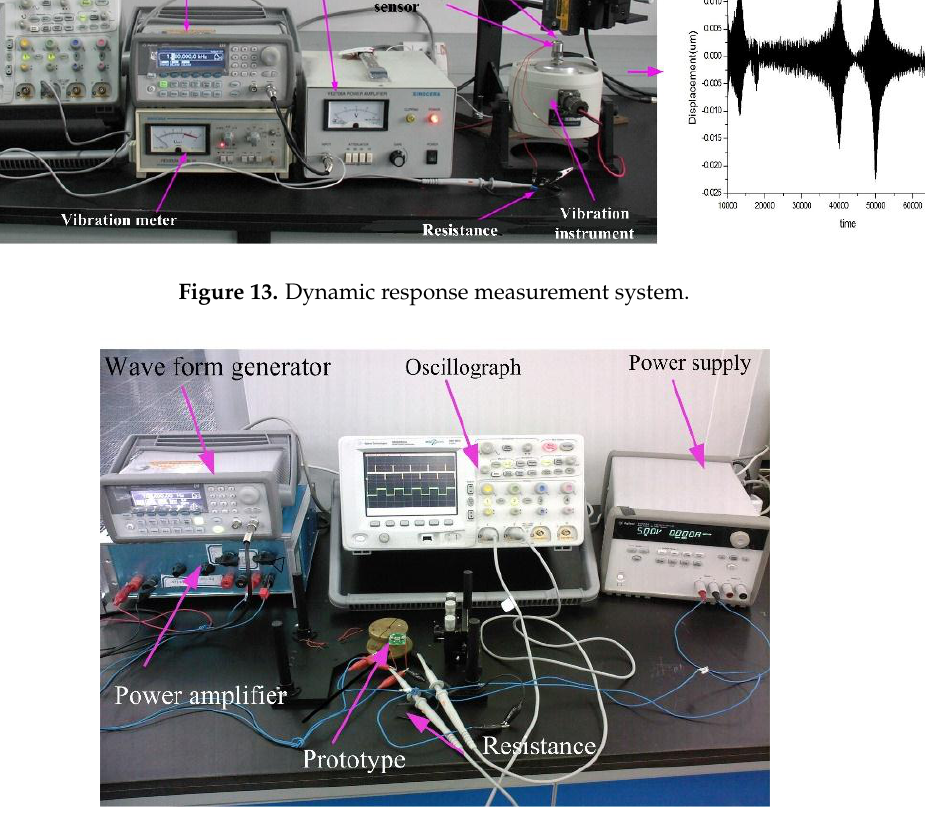
Figure 14. Bistabe measurement system of the prototype.